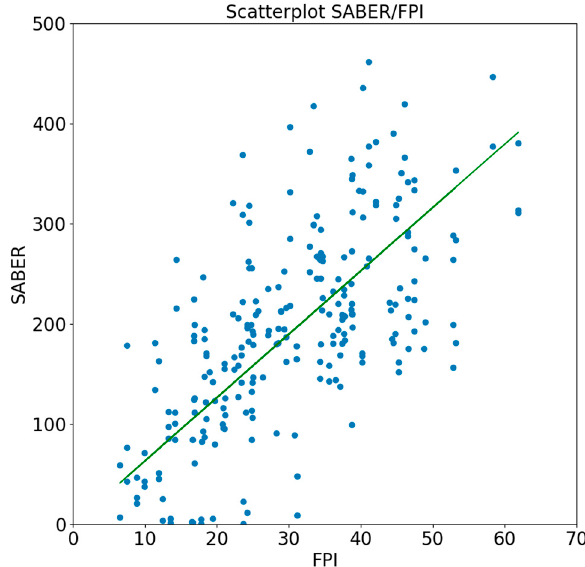
Figure 2. Scatter diagram (blue points) and regression line (green line) from FPI and SABER data of I 557.7 nm.